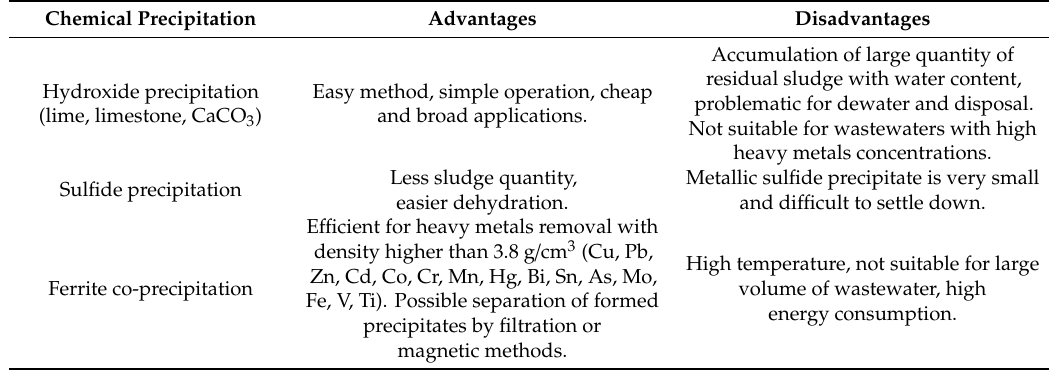
Table 2. Advantages and disadvantages of the chemical precipitation function of the coagulant used in the